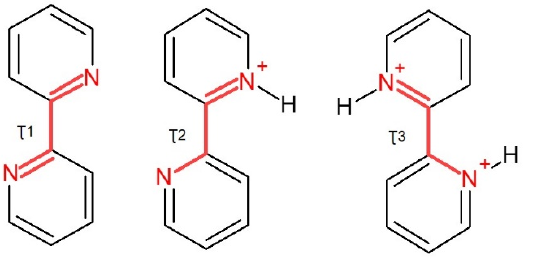
Figure 5. Schematic representation of the search fragments showing the torsion angles. Ʈ 1, Ʈ 2, and Ʈ 3 represent the torsion angles for BPY, BPY H +, and BPY 2H + , respectively.